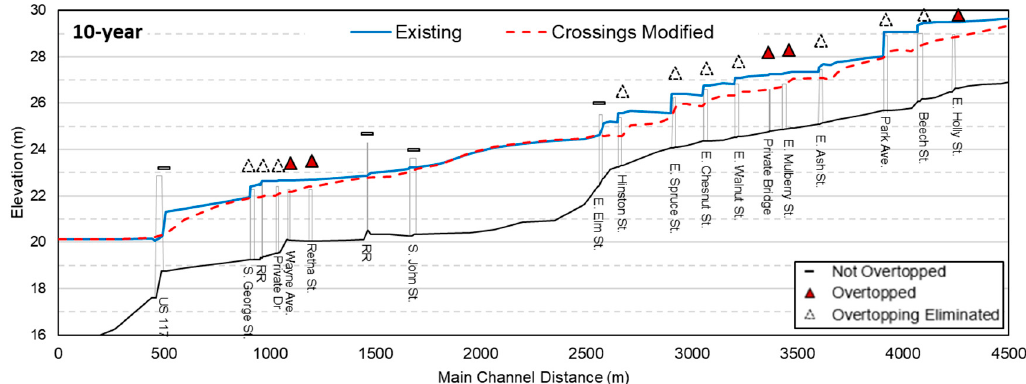
Figure 6. Water surface profiles for the Existing Condition and the Crossings Modified scenario for the 10-year event.